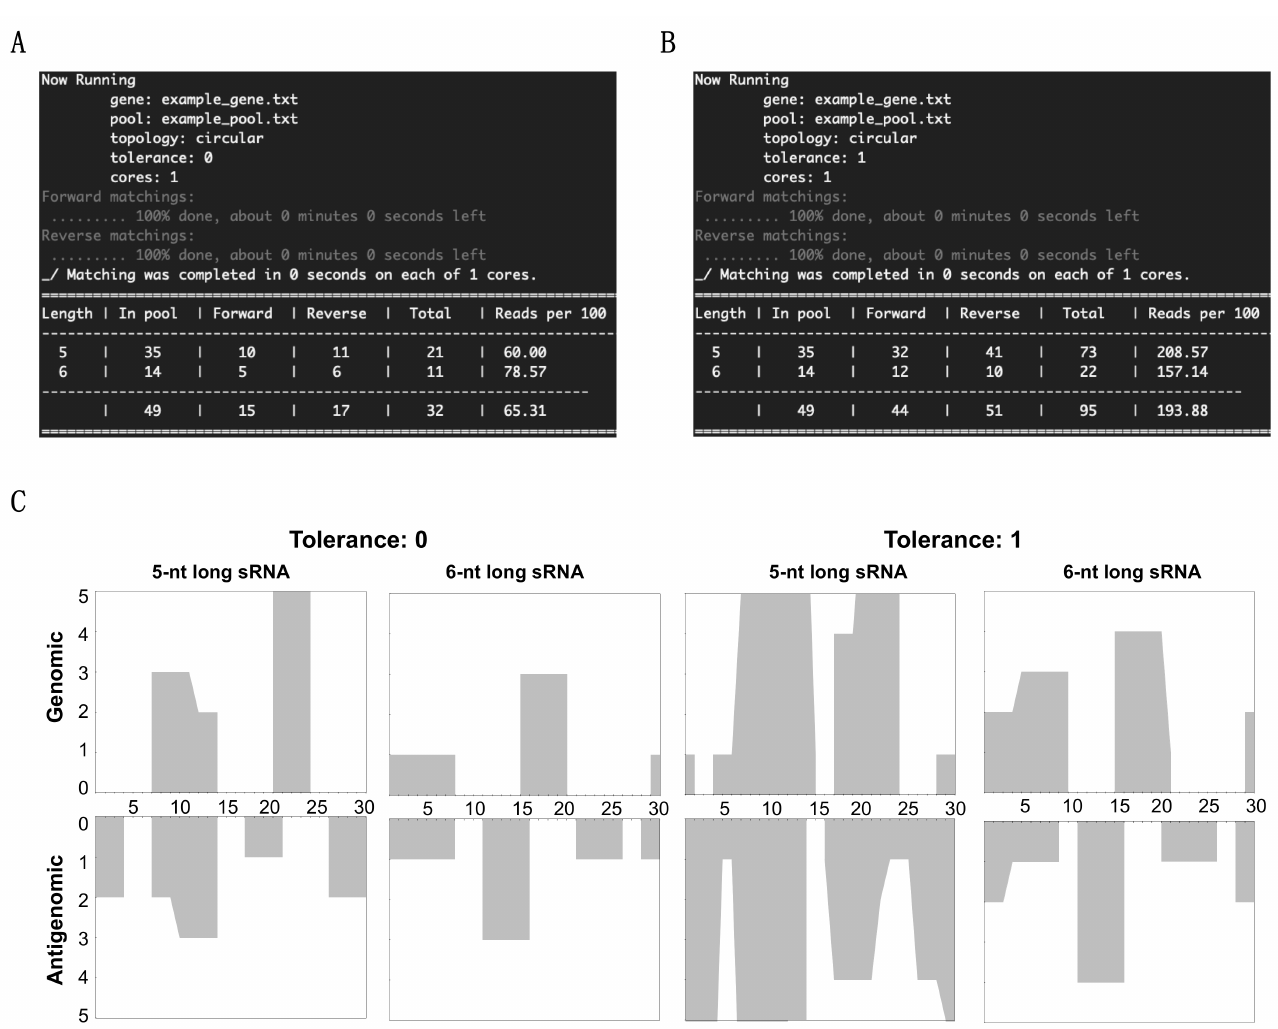
Figure 1. sRNA profiler data output for the test sample. ( A ) Summary of the mapping data obtained from “0” tolerance and ( B ) “1” tolerance levels. ( C ) Profiling of the mapped sRNAs on the 30-nt long circular test genome at both the “0” and the “1” tolerance levels for 5- and 6-nts long